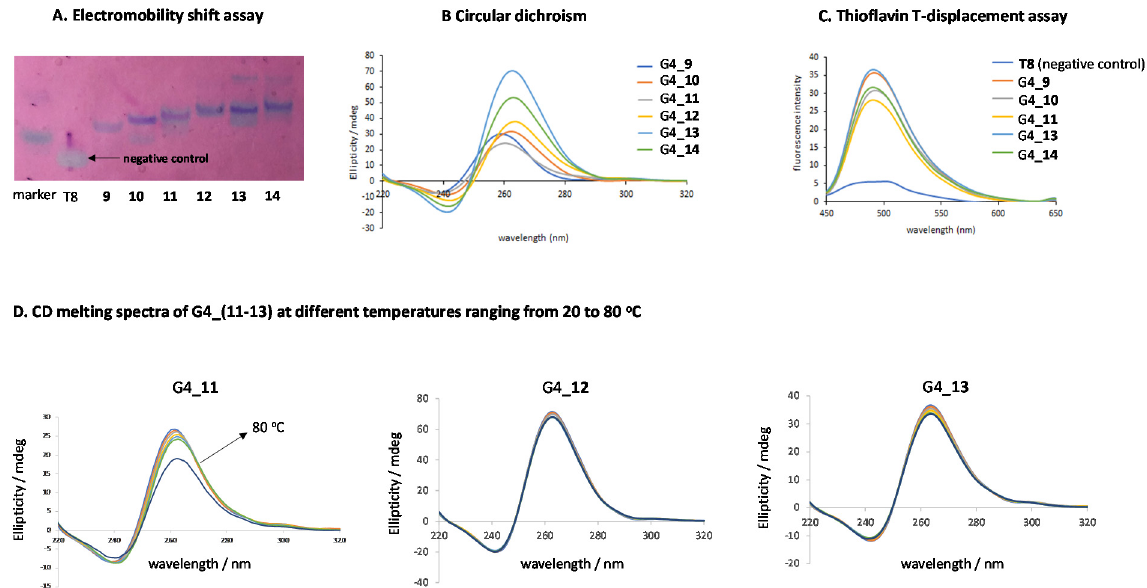
Figure 5. Native PAGE analysis, circular dicrhoism (CD), CD melting spectra, and Thioflavin T (ThT)-displacement assay of G-quadruplex forming oligonucleotides G4_( 9-14 ). ( A ) Native 20% polyacrylamide gel electrophoresis analysis of G-forming oligonucleotide conjugates ( 9-14 ) in 1X PBS supplemented with 100 mM KCl. A mixture of bromophenol blue and xylene cyanol was used as a marker. T8 is an oligonucleotide containing 8 thymidines that was used as a negative control as it is unable to form a quadruplex and indicate the position of a single-stranded 8-mer. ( B ) CD spectra measured at 20 °C showing positive and negative bands at 264 and 240 nm, respectively. This confirms the presence of a parallel G-quadruplex construct. G-constructs were obtained in 10 mM sodium cacodylate, 110 mM NaCl buffer; ( C ) ThT displacement assay shows the emitted fluorescence of ThT probe when bounded to G-quadruplex structures. A T-rich oligonucleotide (T8) was used as a negative control; ( D ) CD melting spectra at several temperatures ranging from 20 to 80 °C with a heating rate of 1.0 °C min − 1 . All conjugates showed remarkable stabilities except, for G4_ 11, which had a band intensity that was slightly reduced.